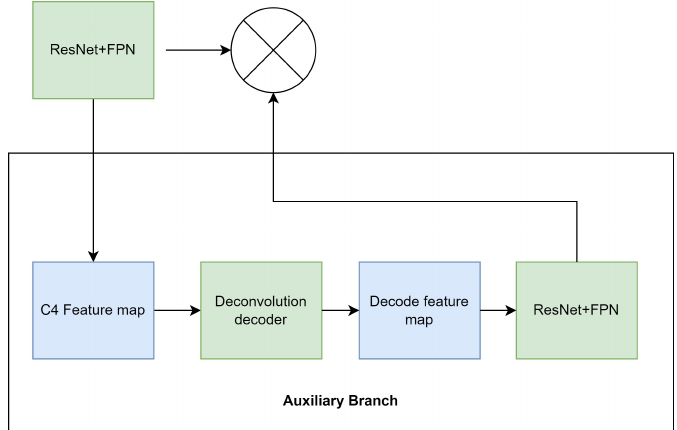
Figure 8. The feature fusion design of CloudRCNN (feature